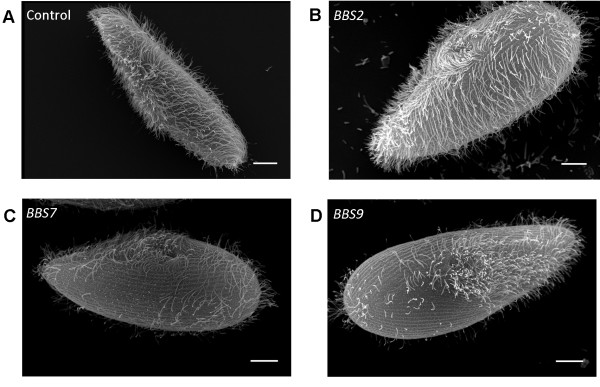
Scanning electron microscopy images of control and BBS depleted cells. (A) Control cell, (B) BBS2-depleted cell, (C) BBS7-depleted cell and (D) BBS9-depleted cell. Scale bars are 10 μm; these are representative images.